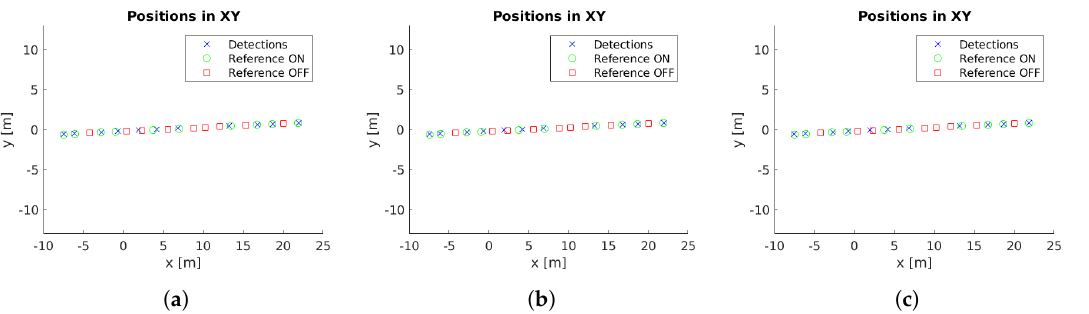
Figure 7. Cluster centers and reference values for case study 2. ( a ) Unconstrained system [31], ( b ) system with reprojection error filtering, and ( c ) system with filtering and orientation